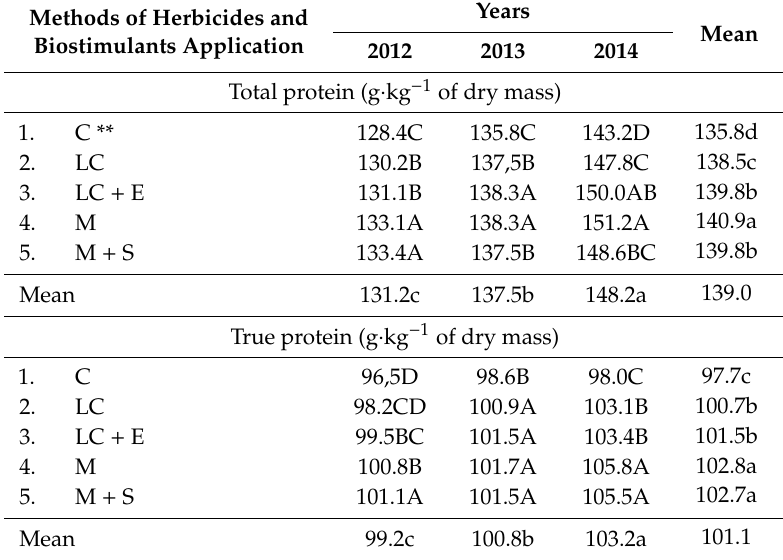
Table 6. Total and true protein content in dry matter of potato tubers depending on weather conditions. Methods of Herbicides and Biostimulants Application